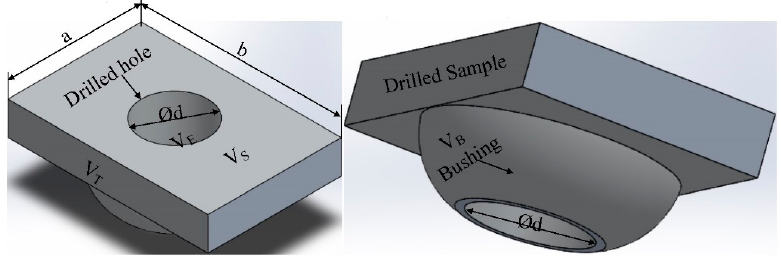
Figure 5. Geometrical properties of samples.